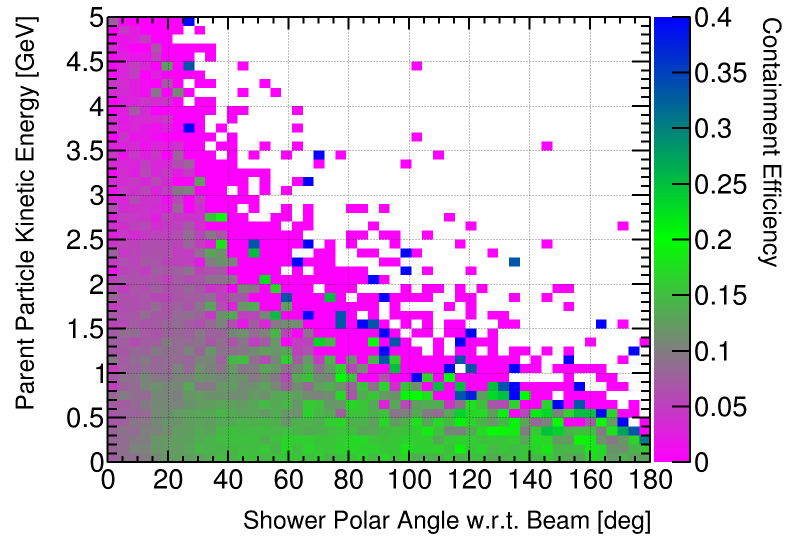
Figure 31. Efficiency for containing both photon-induced showers from π 0 decays in the ArgonCube 2 2 module, as a function of the π 0 kinetic energy and angle w.r.t the incoming neutrino direction. × Containment is defined as 90% of the energy being deposited in an active volume of a detector, and ≥ all primary π 0 ’s produced inside the 2 2’s active volume are ×